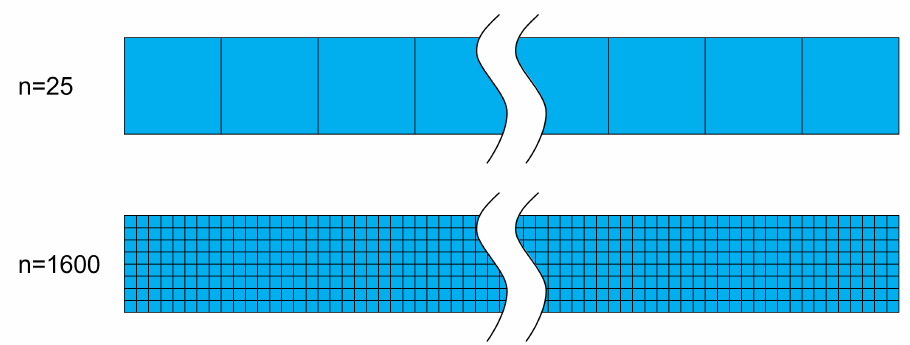
Figure 11. Coarse (top) and fine (bottom) mesh used for the convergence analysis of the cantilever beam problem with total element number n. Not all elements are shown for better visualization.